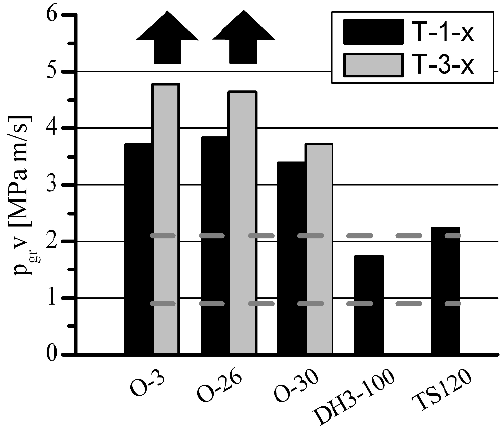
Figure 7. The influence of h-BN on the load capacity of porous sleeves at n = 600 rpm.